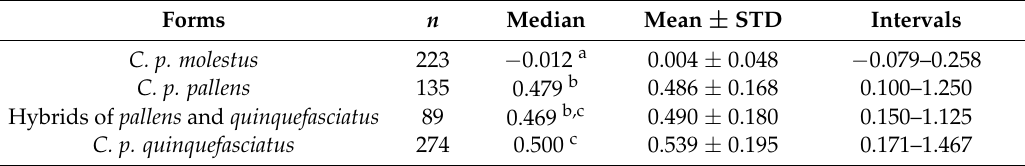
Table 3. DV/D ratios of Culex pipiens complex members in Shanghai downtown, China. Forms n Median Mean ± STD Intervals C. p.